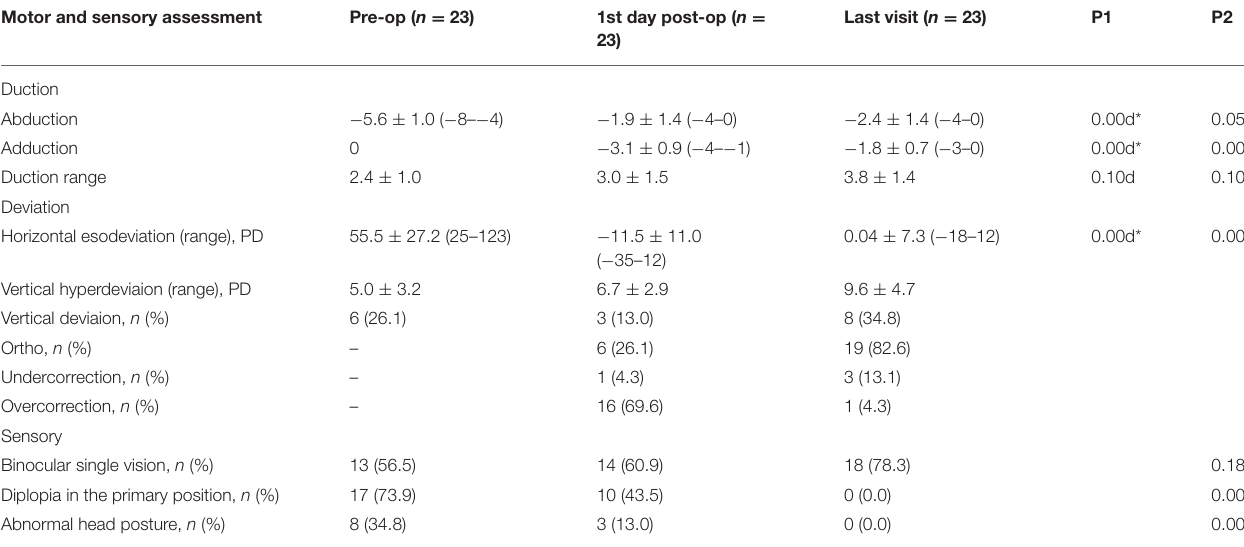
TABLE 3 | Pre- and Postoperative motor/sensory features of patients with unilateral complete abducens nerve palsy. Motor and sensory assessment